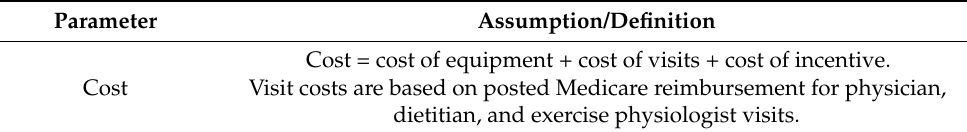
Table 2. Definitions and assumptions made for hypothetical cost-effective analysis.